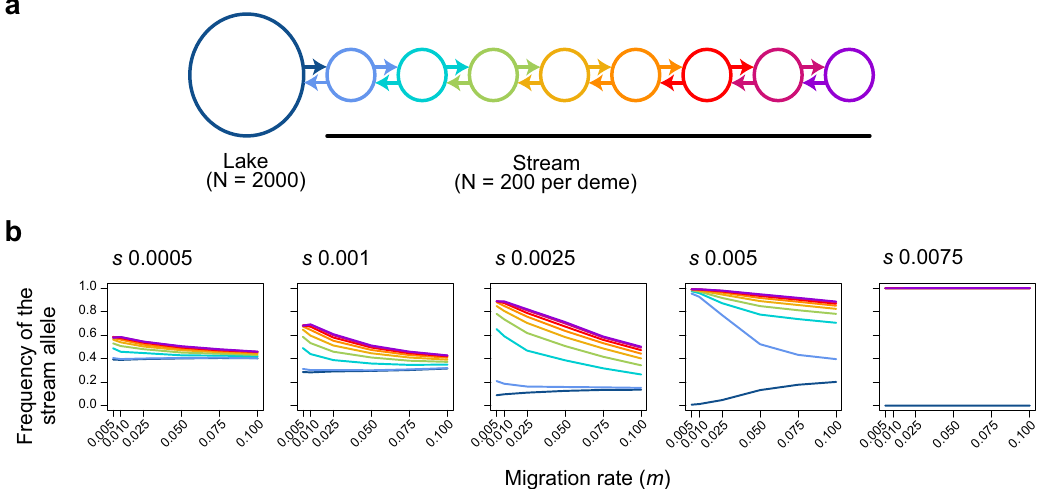
Fig. 6 Simulated divergence with gene fl ow across the lake-stream habitat transition. a Schematic of the stepping-stone model. Arrows indicate migration between neighboring demes. b Median frequency of the allele favored in the stream across 100 loci under selection after 1000 generations of evolution, averaged across 20 simulation replications for different combinations of migration rate and selection strength (selection coef fi cient s given on top of each panel). The demes are color coded as in a . In the rightmost panel, all stream demes are fi xed for the stream allele hence the lines